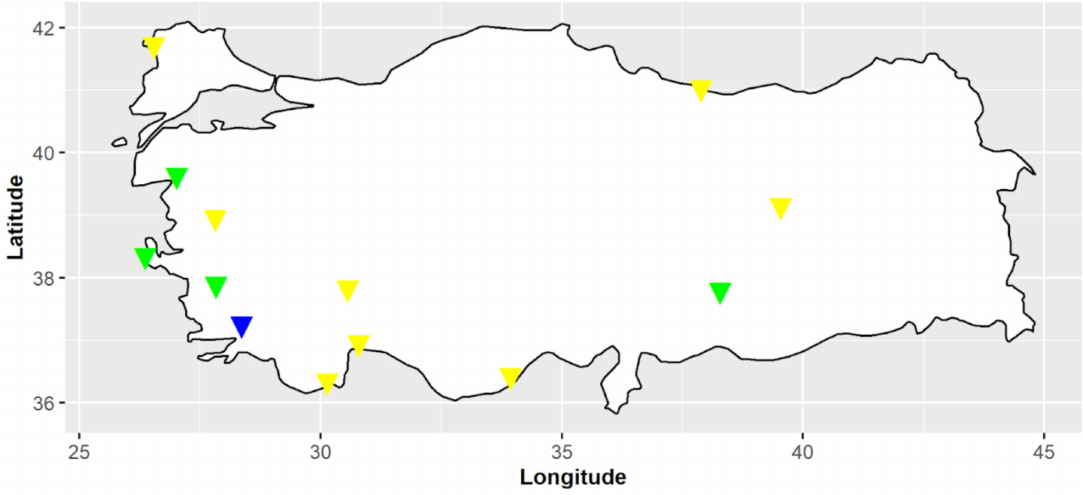
Figure A14. Same as Figure A13 but for January (See Figure A13 for legend).